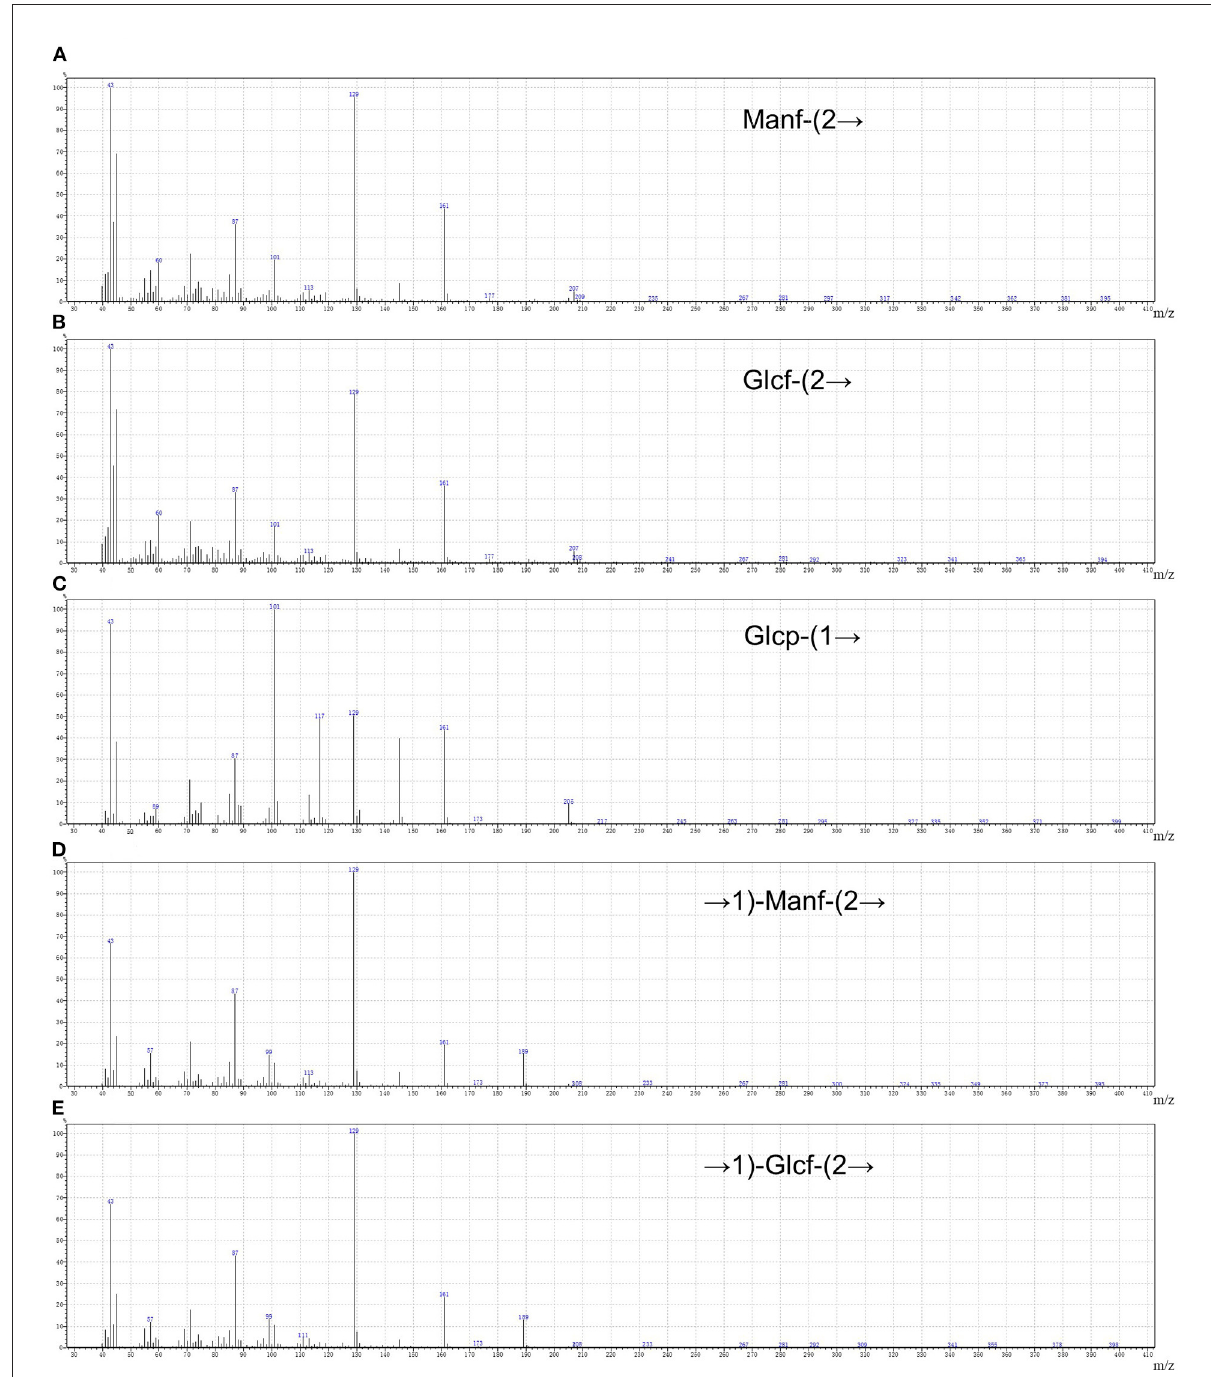
FIGURE2 The five methylated sugar residues of WSGP by Using GC–MS. 1,3,4,5-Me 4 -Manf (A) , 1,3,4,5-Me 4 -Glcf (B) , 2,3,4,6-Me 4 -Glcp (C) , 3,4,5-Me 3 -Manf (D) , and 3,4,5-Me 3 -Glcf (E) . The data were expressed as means ± SD from three independent experiments.